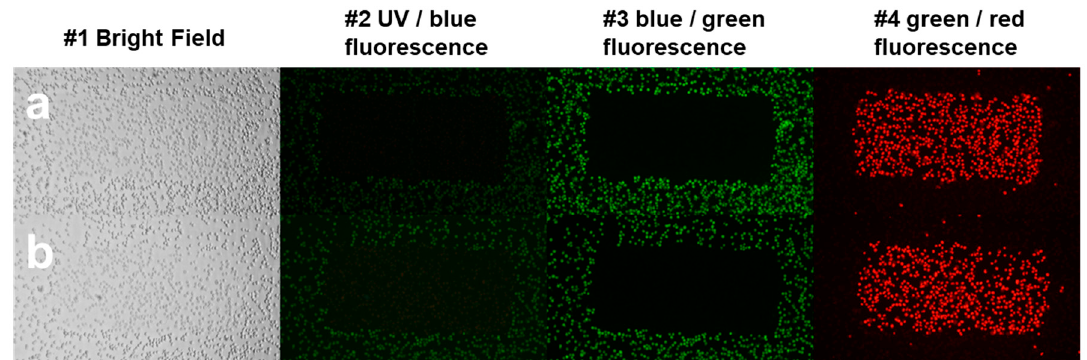
Figure 4. Phototoxicity measurements of HeLa cells labeled with AO or DM. Localized phototoxicity was induced in HeLa cells applying 488-nm laser light illumination. In columns #3 and #4 we can easily distinguish live cells appearing as green (AO or DM staining) from cells targeted to phototoxic death appearing in red (PI staining). The cells were illuminated in 63 cycles in the presence of 2.5 µM AO ( a , top row images) or DM ( b , bottom row images) and propidium iodide in both cases with an iCys LSC system. Adherent cells were maintained under physiological conditions during the approximately five-hour procedure. Then, conventional bright-field and epifluorescence microscopic images of the LSC-illuminated area were recorded. Column #1: bright field of view, column #2: UV/blue fluorescence, column #3: blue/green fluorescence and column #4: green/red fluorescence images (excitation light/emission light). A detailed explanation of the experimental setup is described in the caption to Figure 5, and the materials and methods.